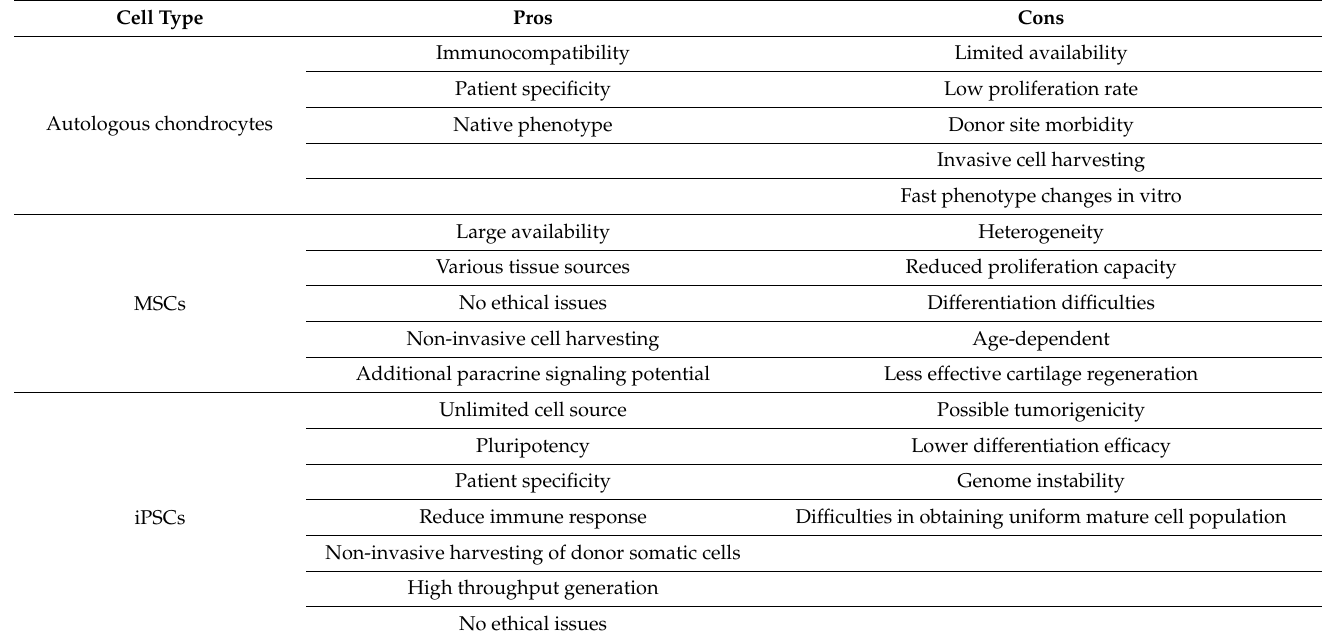
Table 1. Comparison of different types of stem